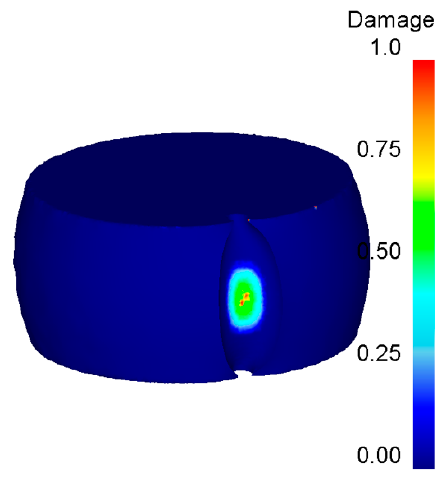
Figure 36. Simulation model of notched cylinder compression.